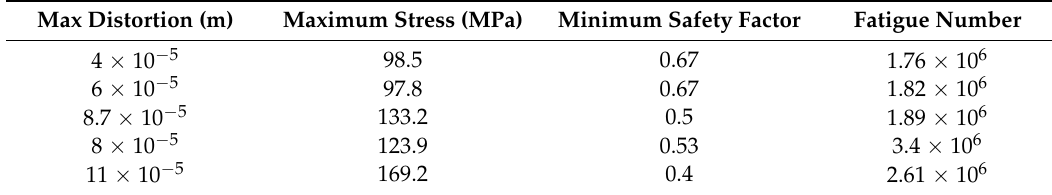
Table 3. Shell strength and fatigue analysis results.